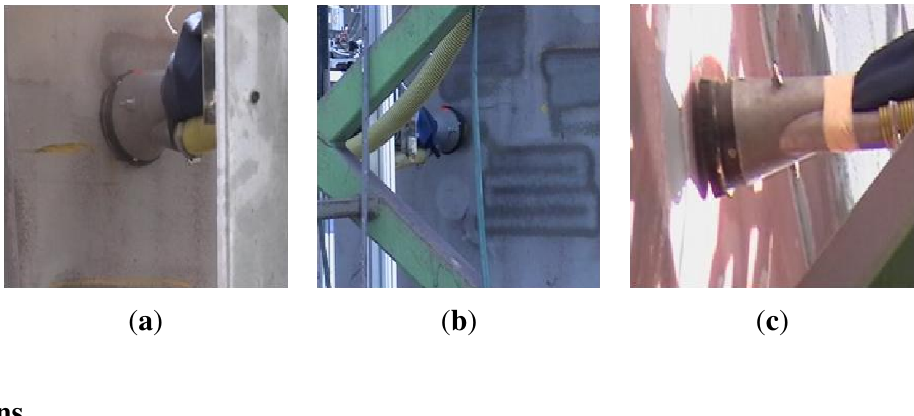
Figure 23. Grit blasting process performed on a vertical